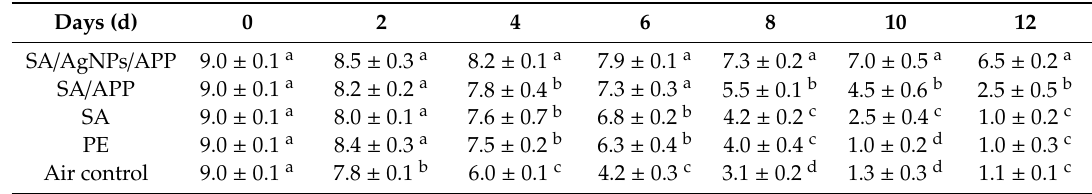
Table 4. Sensory evaluation of strawberry